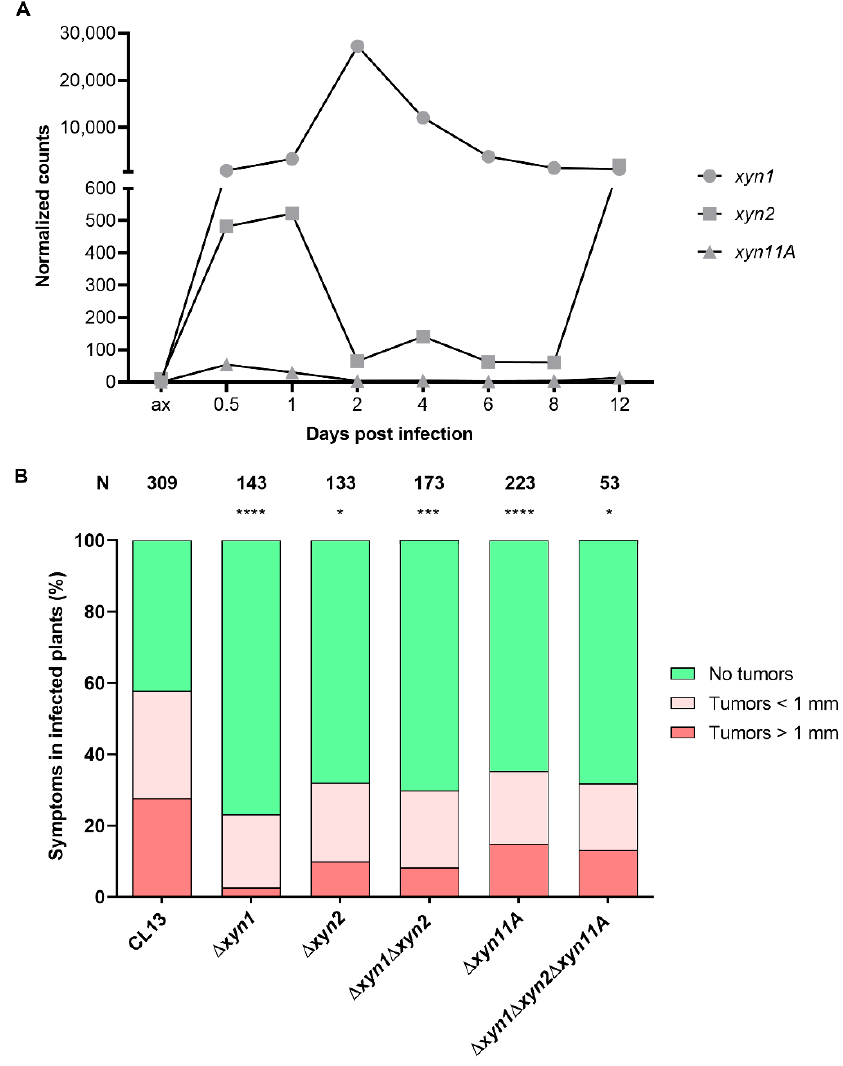
Figure 2. Ustilago maydis xylanases are differentially expressed during infection and are required for full virulence. ( A ) xyn1 , xyn2 m and xyn11A expression levels represented as normalized counts ob- tained from high-throughput transcriptomic analysis of U. maydis during pathogenesis [21]. ( B ) Quantification of symptoms for plants infected with indicated strains 14 days post infection. Total number of infected plants is indicated above each column. At least three biological replicates were analyzed. Mann–Whitney statistical test was performed for each mutant versus corresponding wild- type strain (* p -value < 0.05; *** p -value < 0.005; **** p -value < 0.001).